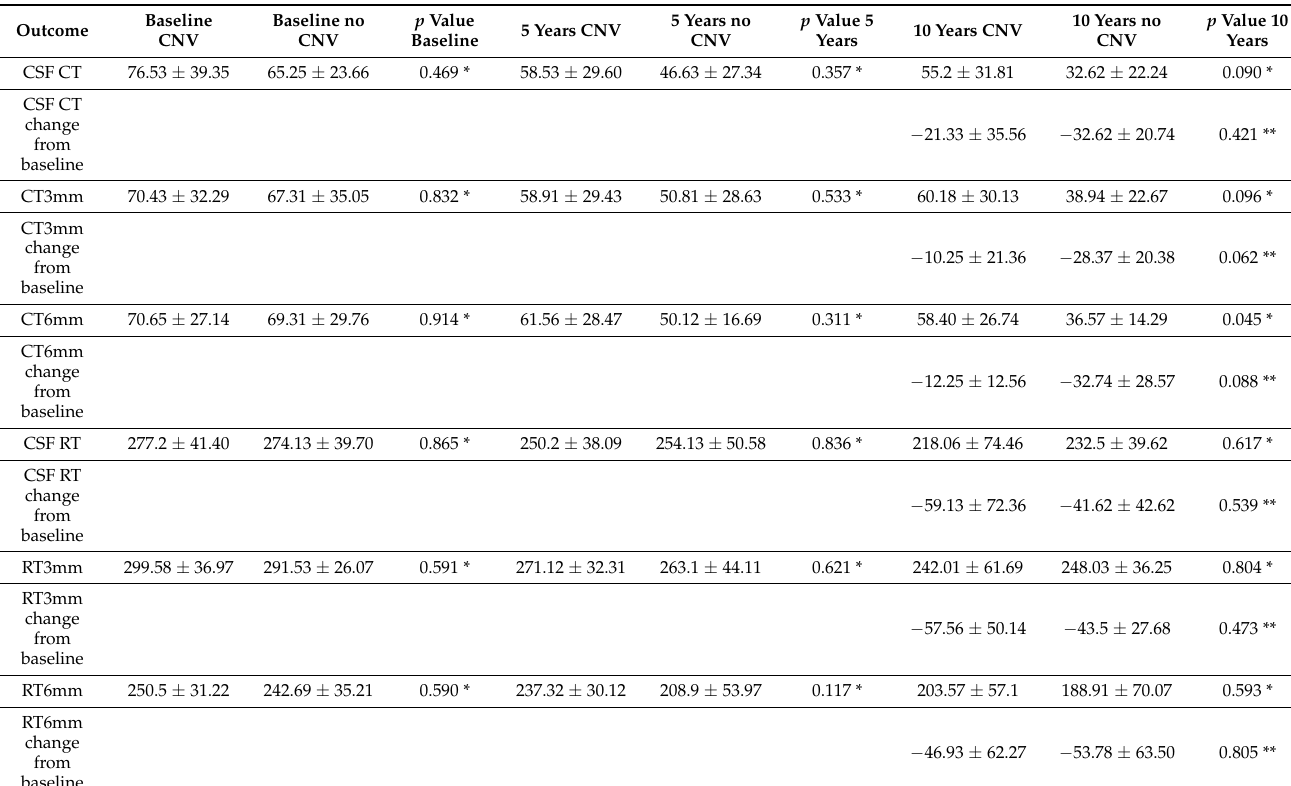
Table 6. Comparative analysis between patients and